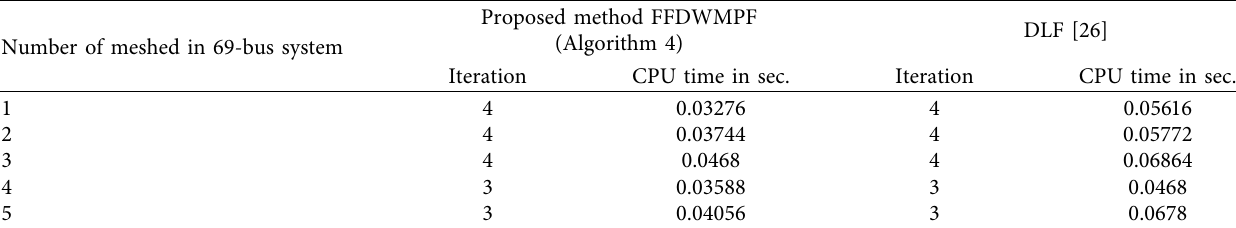
Table 8: Comparison of the CPU execution time of the balanced 69-bus weakly meshed